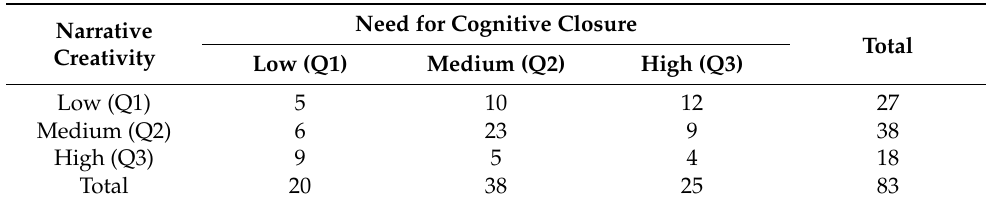
Table 2. Contingency table showing the number of participants classified by levels of narrative creativity and the need for cognitive closure.